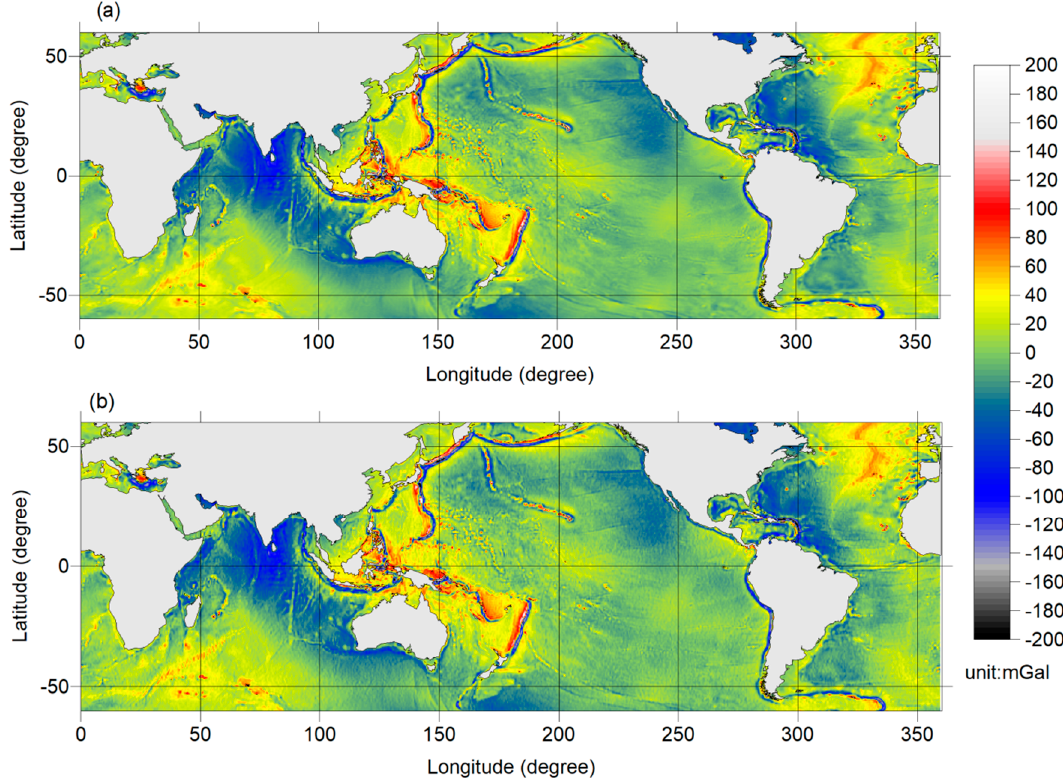
δ from EGM2008; ( b ) the combined g